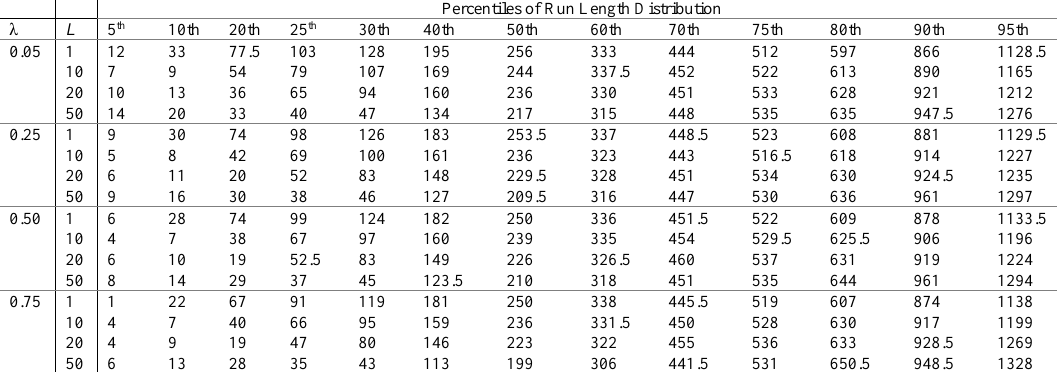
Table 2. Percentiles of the run-length distribution for the synthetic EWMA median chart based on RSS scheme when n =5, δ =0 for L =1, 10, 20, 50.